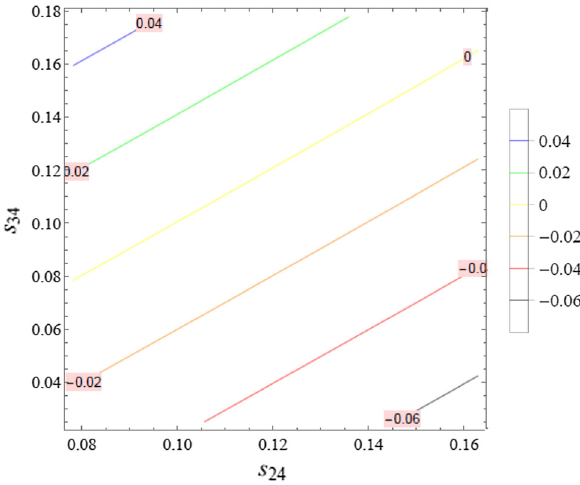
Fig. 6 r u versus s 24 and s 34 with s 24 ∈ ( 0 . 0782 , 0 . 163 ) and s 34 ∈ ( 0 . 025 , 0 . 178 )